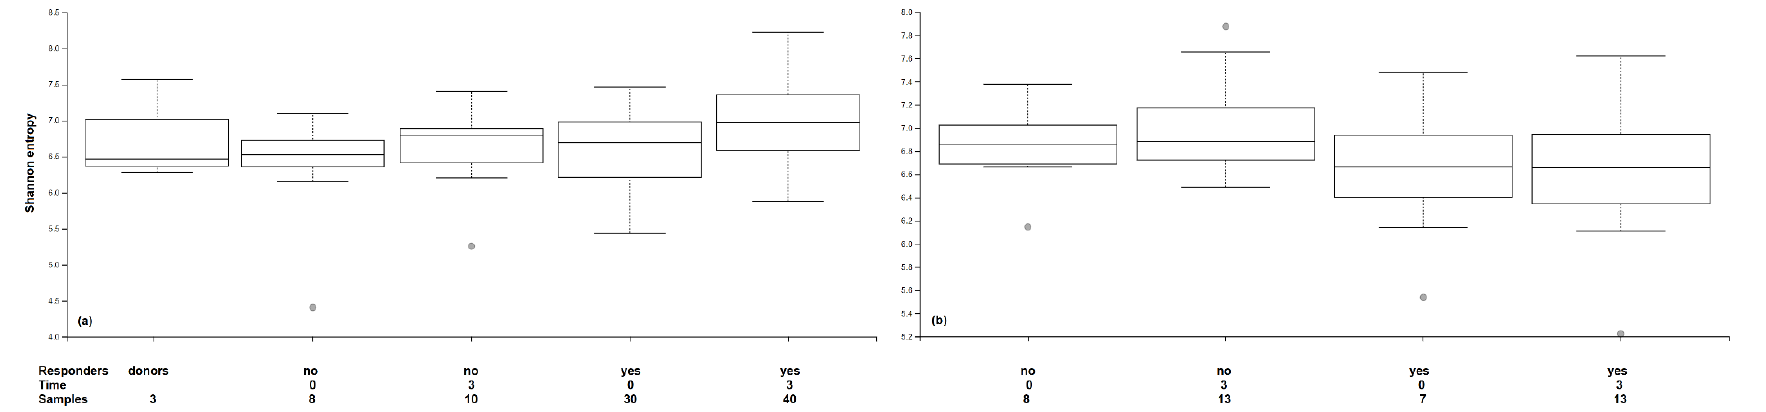
Figure 2. Microbial diversity expressed as Shannon entropy index of treatment responders and non-responders for ( a ) 5-aminosalicylates group and ( b ) fecal microbial transplantation group and the donors. The samples are grouped based on responsiveness to the treatment (yes/no) and time point of a sample collection 0 (before therapy) and 3 (weeks 1–12), the circle symbol represents outliers.